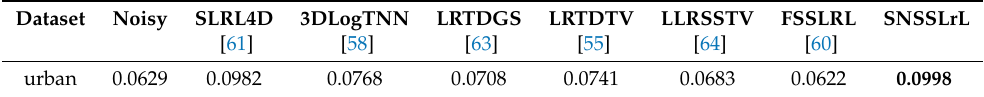
Figure 12. The comparison of the horizontal mean profiles of band 210 of the constructed urban dataset by different denoising methods. Table 3. Q-metric of the reconstructed results of the competing methods on urban dataset.